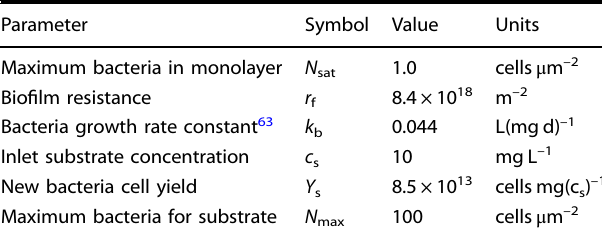
Table 3. Parameters used for the bio fi lm portion of the